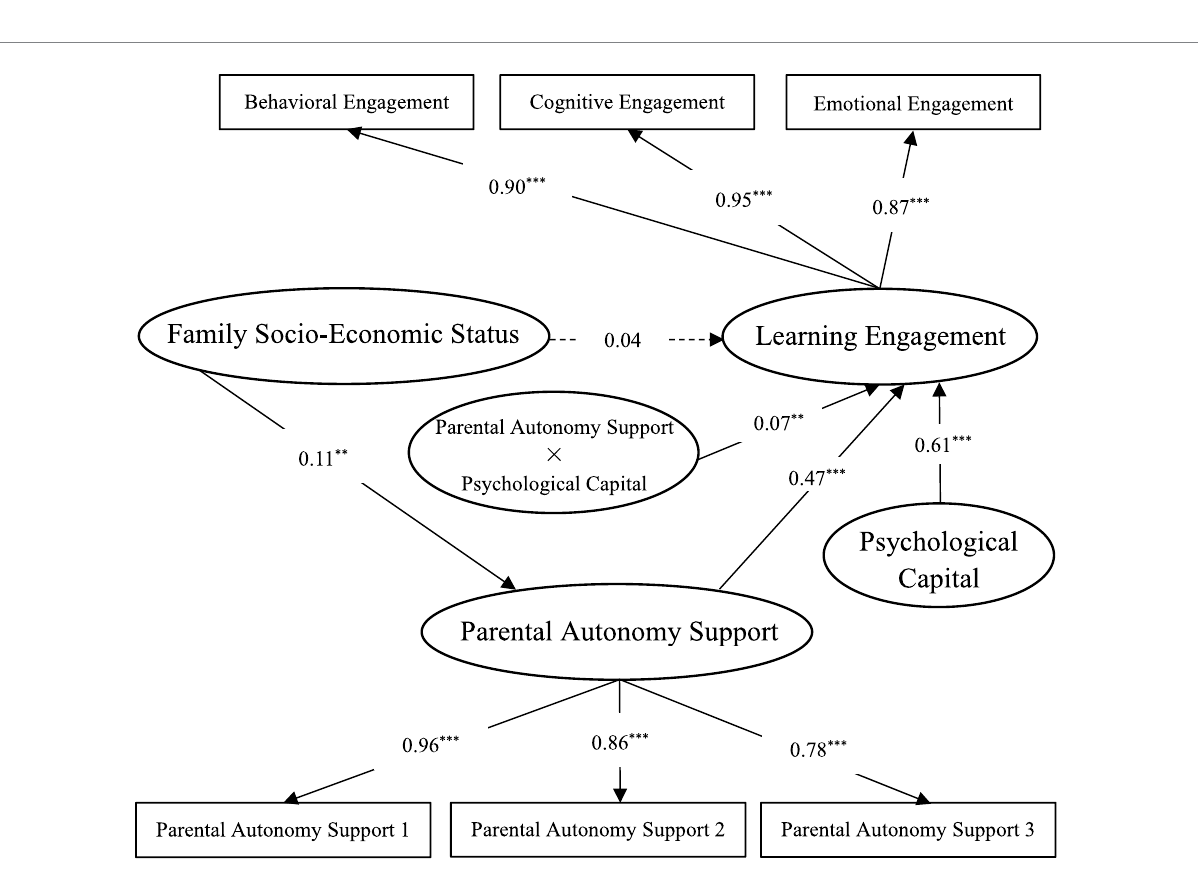
FIGURE 3 Standardized model of psychological capital moderating the relationship between parental autonomy support and learning engagement. * p < 0.05, ** p < 0.01, *** p <